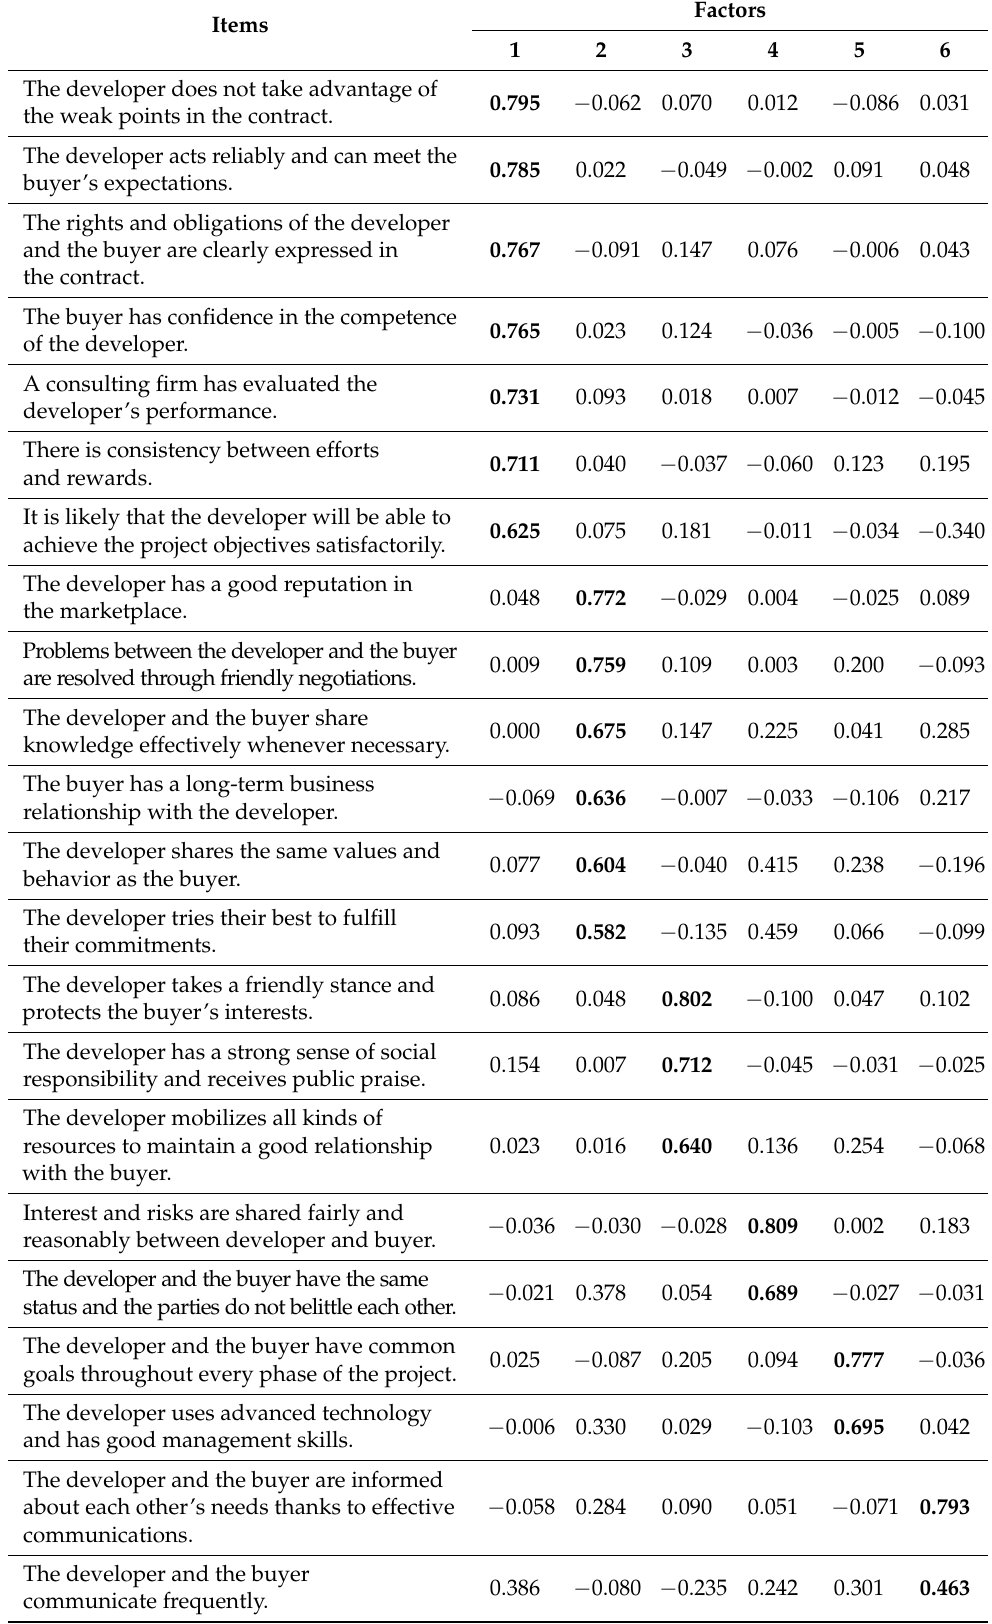
Table 8. Factor pattern of the trust construct.